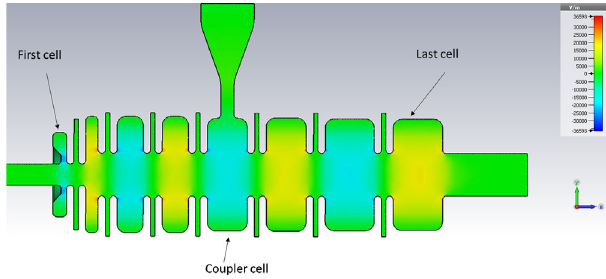
FIG. 9. Image of the final linac design from CST after completion of the cell length optimization.